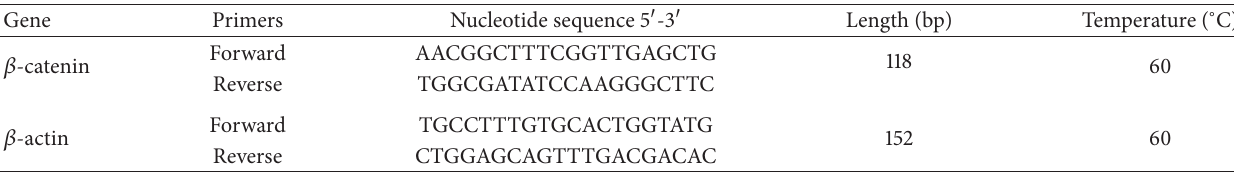
Table 1: Nucleotide sequence of the primers used in real-time PCR.